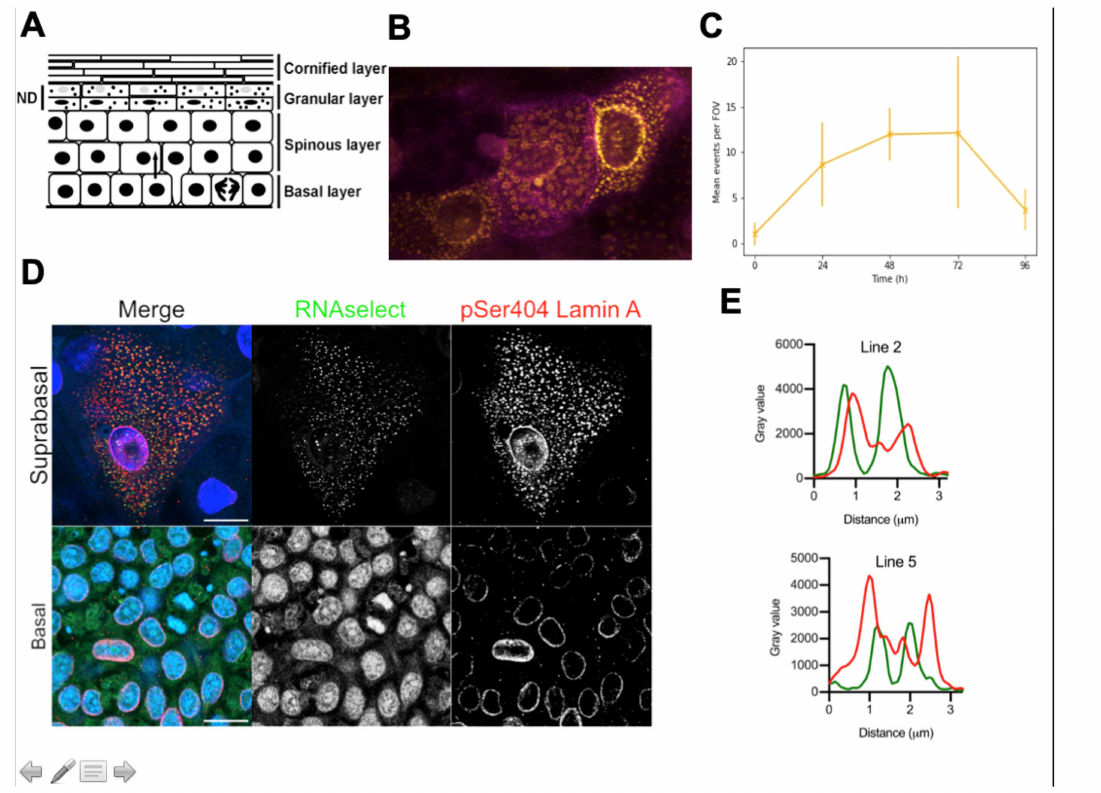
Figure 1. Evidence for Lamin A-positive ribonuclear protein granules in terminally di ff erentiating rat epidermal keratinocytes. ( A ) Schematic of epidermal di ff erentiation. Epidermal di ff erentiation involves nuclear degradation (ND) and the loss of intracellular organelles (adapted from Rogerson et al., 2018). ( B ) pSer404 Lamin A expression (yellow) in the di ff erentiating keratinocytes expressing keratin 10 (magenta) is observed in spherical cytoplasmic bodies [4,5]. ( C ) Expression of these bodies increases over time in confluent culture, peaking at 72 h post-confluency. ( D ) RNAselect detects cytoplasmic RNA bodies in suprabasal keratinocytes. Bar 20 µ m ( E ). Profile plots across these bodies shows co-localisation of pSer404 Lamin A and